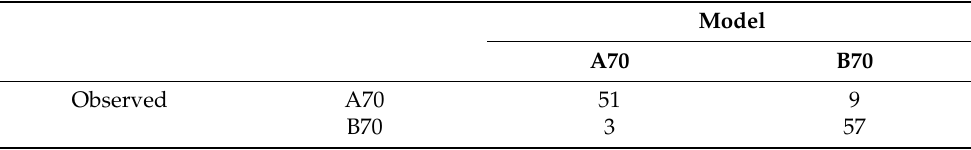
Table 4. Confusion matrix for the training period.